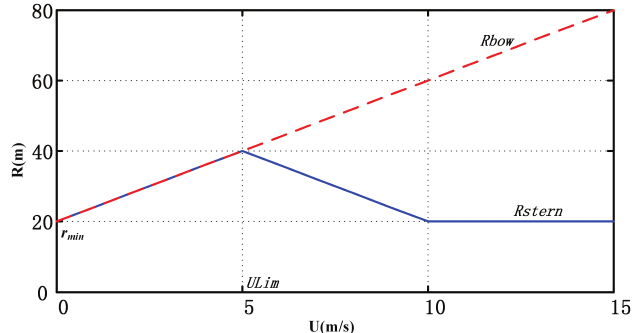
Figure 14. The outputs of target vessel domain model for increasing speed U with T upd = 4 s, r min = 20 m, and ULim = 5 m/s. The dotted line represents the output for the bow section, and the solid line represents the stern section of the target vehicle. r min : minimum radius of the domain model; ULim : the boundary value of speed; Rbow : the semi-major axis of the bow part; Rstern : the radius of stern